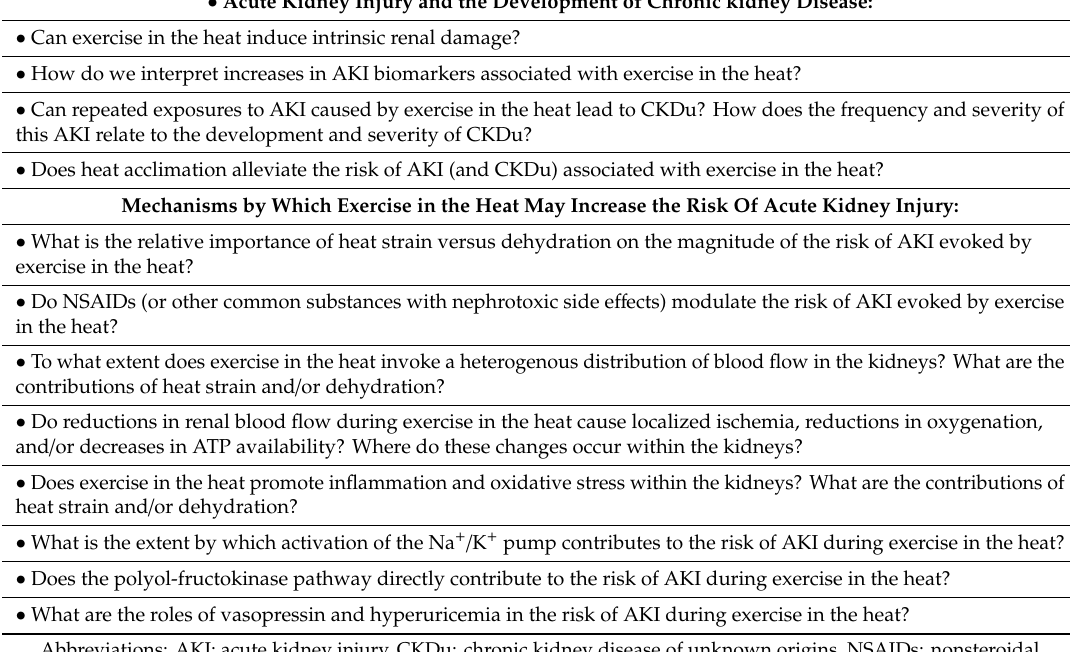
Table 2. Selected identified knowledge gaps regarding the link between exercise in the heat, acute kidney injury and the development of chronic kidney disease in